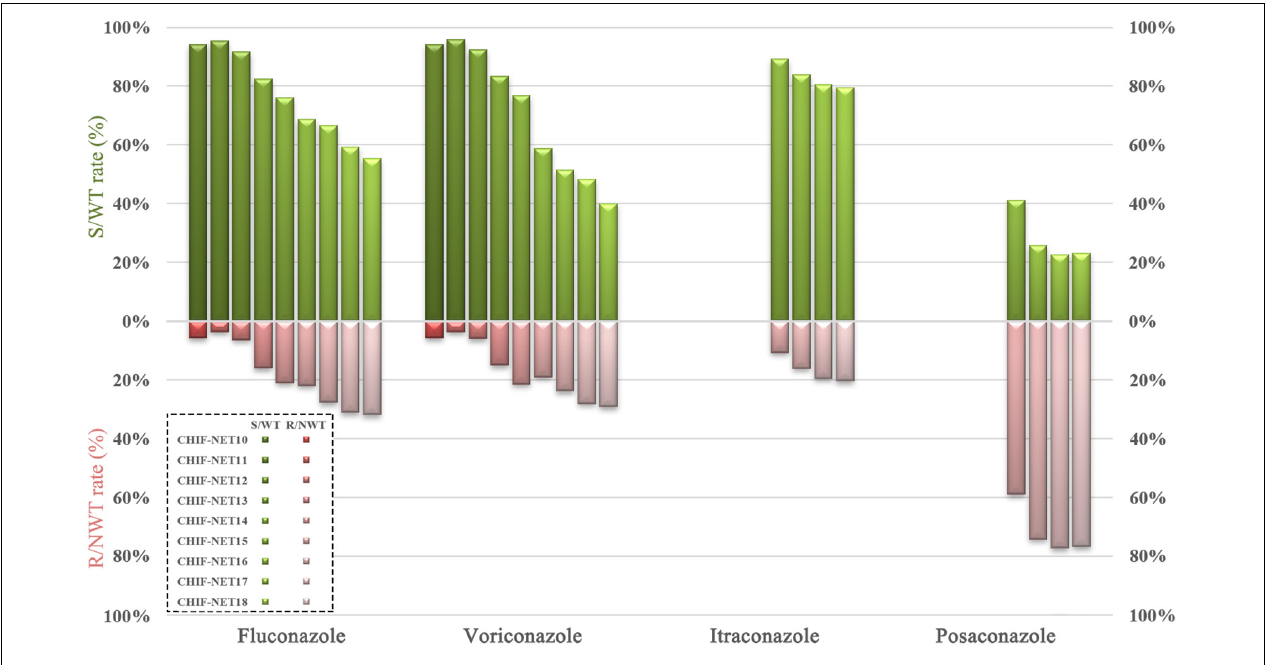
FIGURE 1 | Trends of azole susceptibility in C. tropicalis over a 9-year surveillance. S, susceptible; R, resistant; WT, wild-type; NWT,